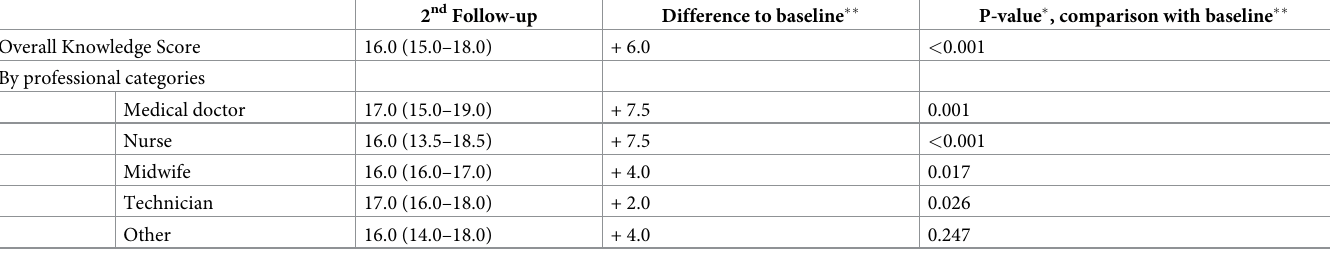
Table 3. Median hand hygiene knowledge score (IQR), Regional Hospital Faranah; maximum score: 25.